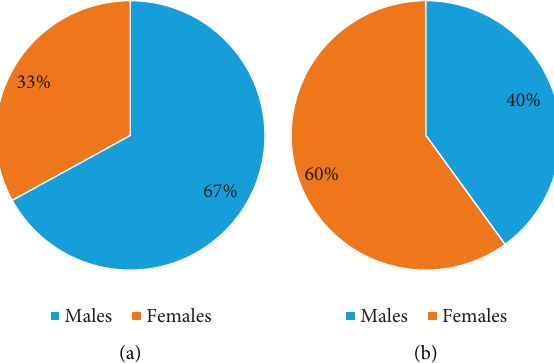
Figure 9: (a) Percentage of the male and female population involved in aquaculture in Nepal. (b) percentage of the male and female population involved in capture fisheries in Nepal, source: [25].